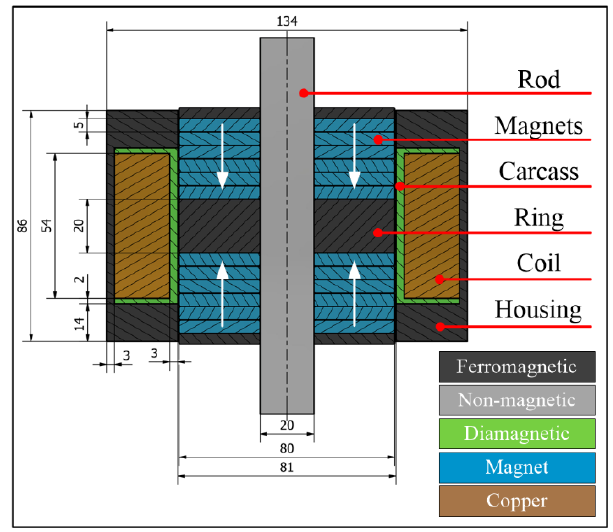
Figure 2. Structure of the harvester.